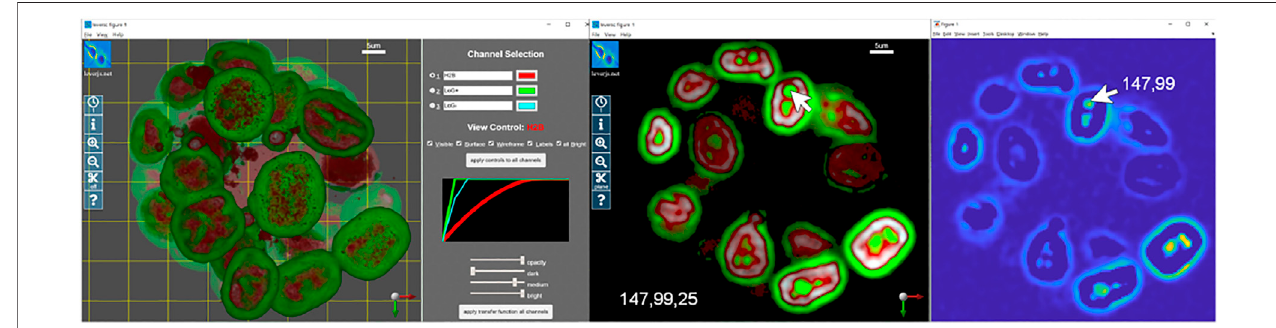
FIGURE 1 | LEVERSC makes quantitative visualization at each step of the image processing pipeline as easy for 3-D multi-channel images as it is for 2-D images. Therealisticrenderingisenabledbyareal-timeanisotropicraycastingwithperspectiveprojection.Therawimageandtwocomputedimagesarevisualizedasafullstack (left), or as a slice at arbitrary orientation through the volume (center). Quantitative visualization recovers the precise 3-D voxel location, shown here with a 2-D single channel image view at Z location 25